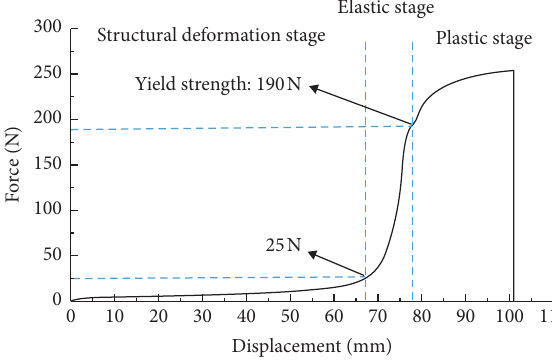
Figure 13: Static tension curve of the single anchored net.